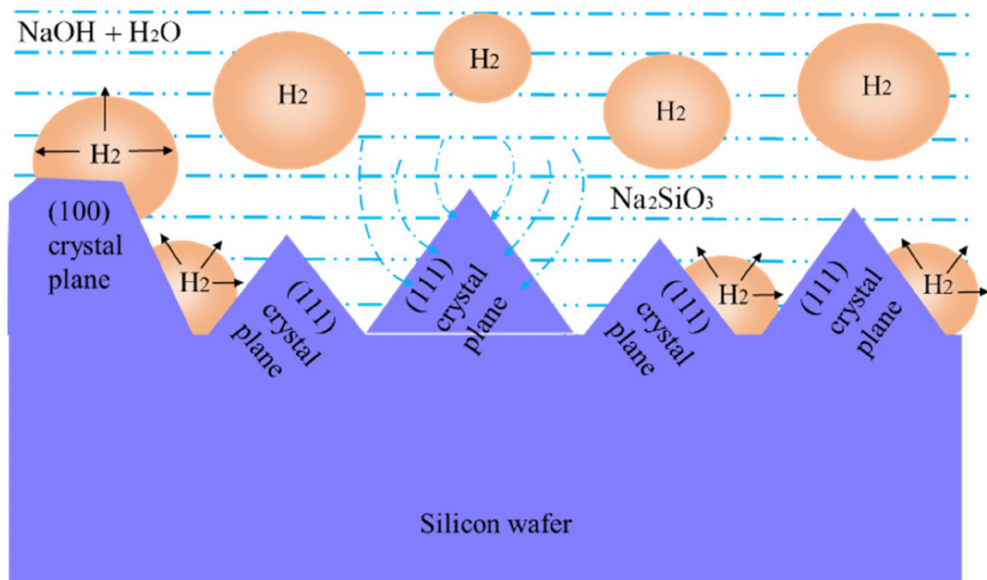
Figure 1. Sectional view of the random distribution of the